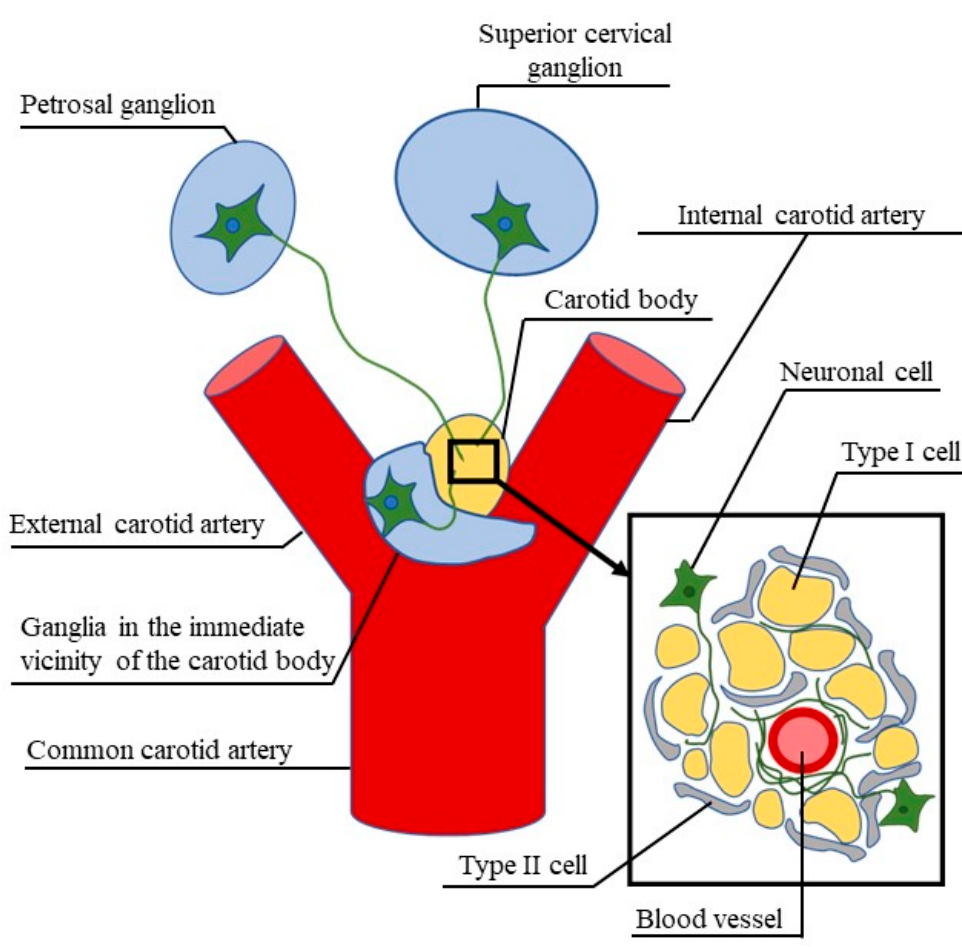
Figure 1. Vasoactive intestinal polypeptide (VIP)-positive neuronal structures (green) supplying the rat carotid body in light of current knowledge.